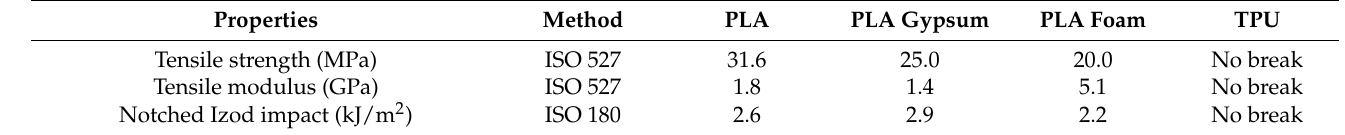
Table 2. Properties of the 3D-printed